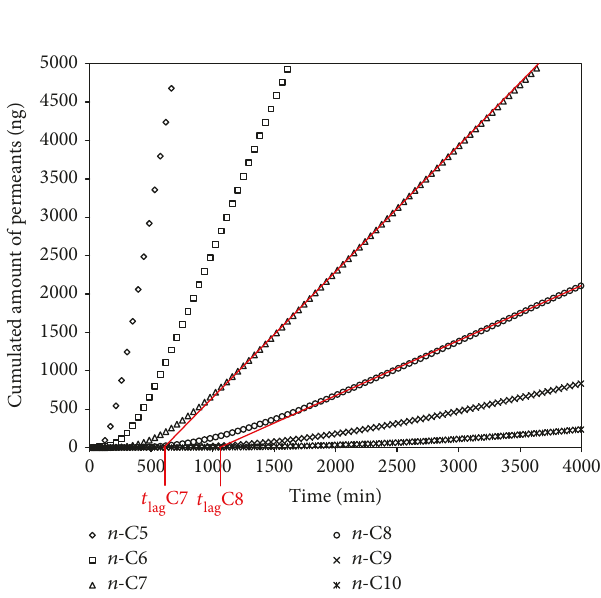
Figure 1: Experimental permeation curves for n -pentane to n -decane at 130 ° C (lag time for n -heptane and n -octane: intercept of the red line on the time